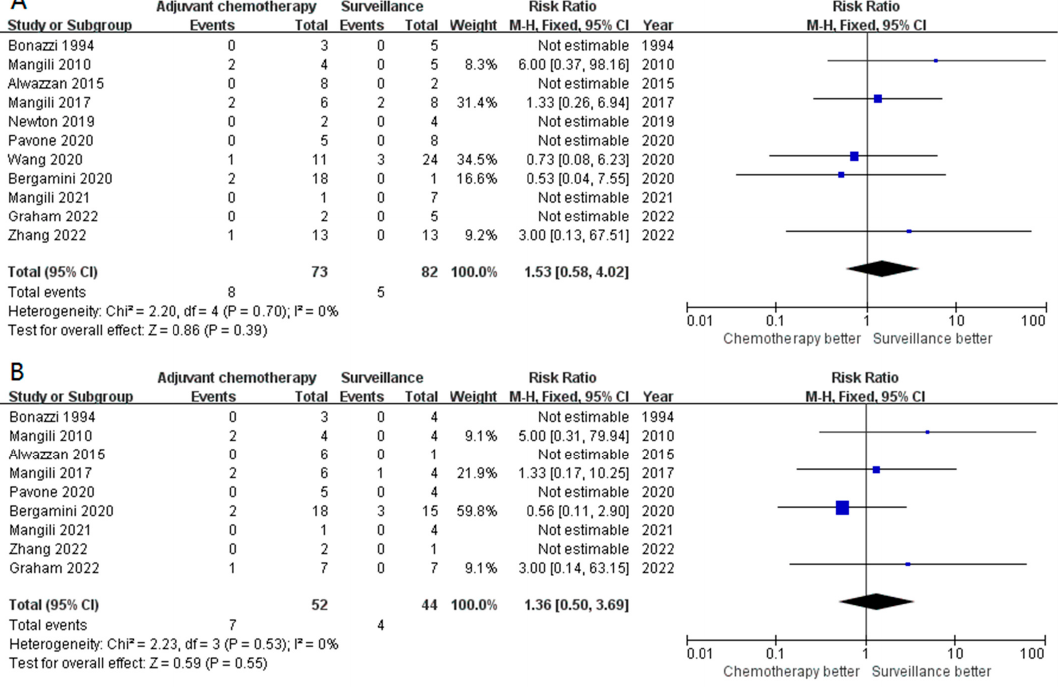
Figure 5. Compared with surveillance, adjuvant chemotherapy did not significantly decrease the risk of recurrence in stage IB-IC POIT ( A ) and stage IB-IC G2-G3 POIT ( B